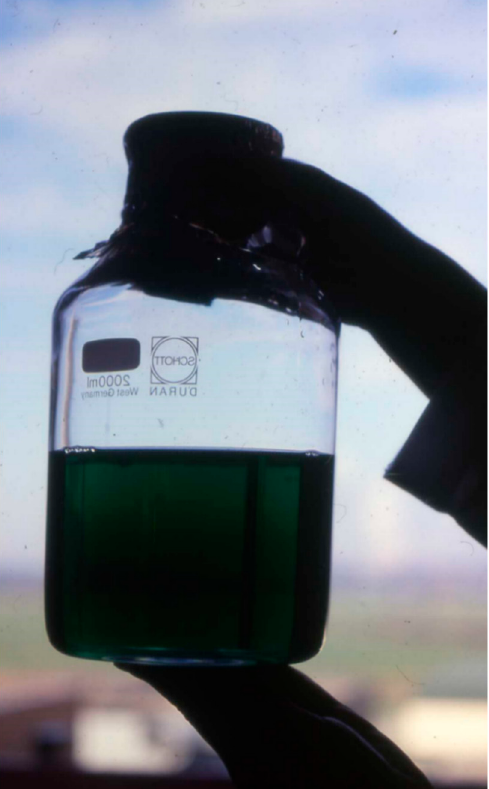
Figure 6. First bottle of human Cu/Zn-SOD isolated from genetically modified Escherichia coli . The bottle contains the whole yield of a 100-l-fermenter; the green solution looks almost black. The poor picture (taken by L. F.) was proudly shown in 1985 at the symposium on “Superoxide and Superoxide Dismutases in Chemistry, Biology and Medicine” organized by Guiseppe Rotilio in Rome (Italy) [242].